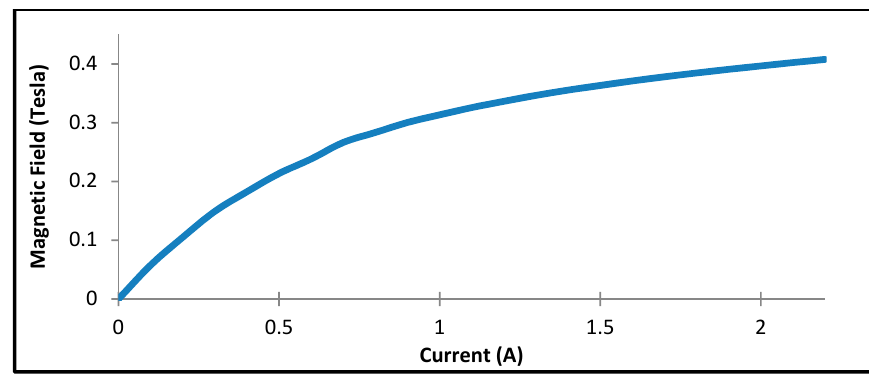
Figure 7. Magnetic flux density along the flow path of the serpentine valve.